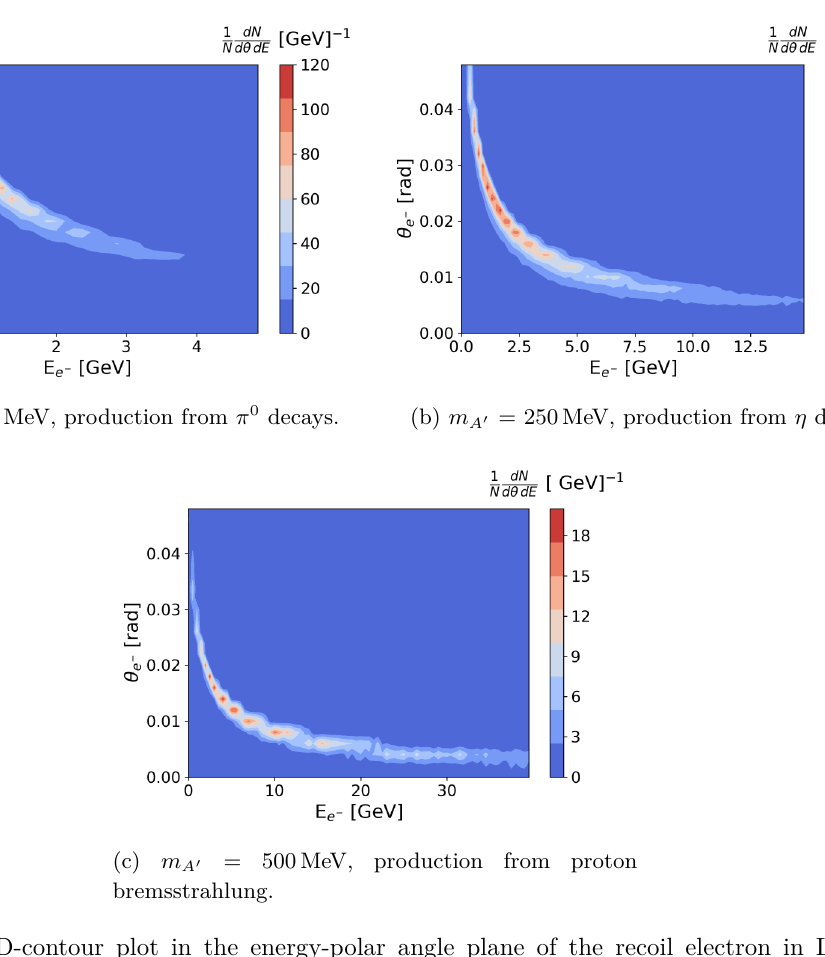
Figure 9. 2D-contour plot in the energy-polar angle plane of the recoil electron in LDM- e − scattering for three different mass DP candidates: (a) 50 MeV, (b) 250 MeV, (c) 500 MeV. The colour range is expressed in arbitrary units. A clear correlation is observed between the mass of the DP candidate and the electron energy-angle spectrum: the higher is the mass the smaller the recoil angle and the higher the associated energy. In the mass range we are interested in, most of the signal lies in the energy region below 10